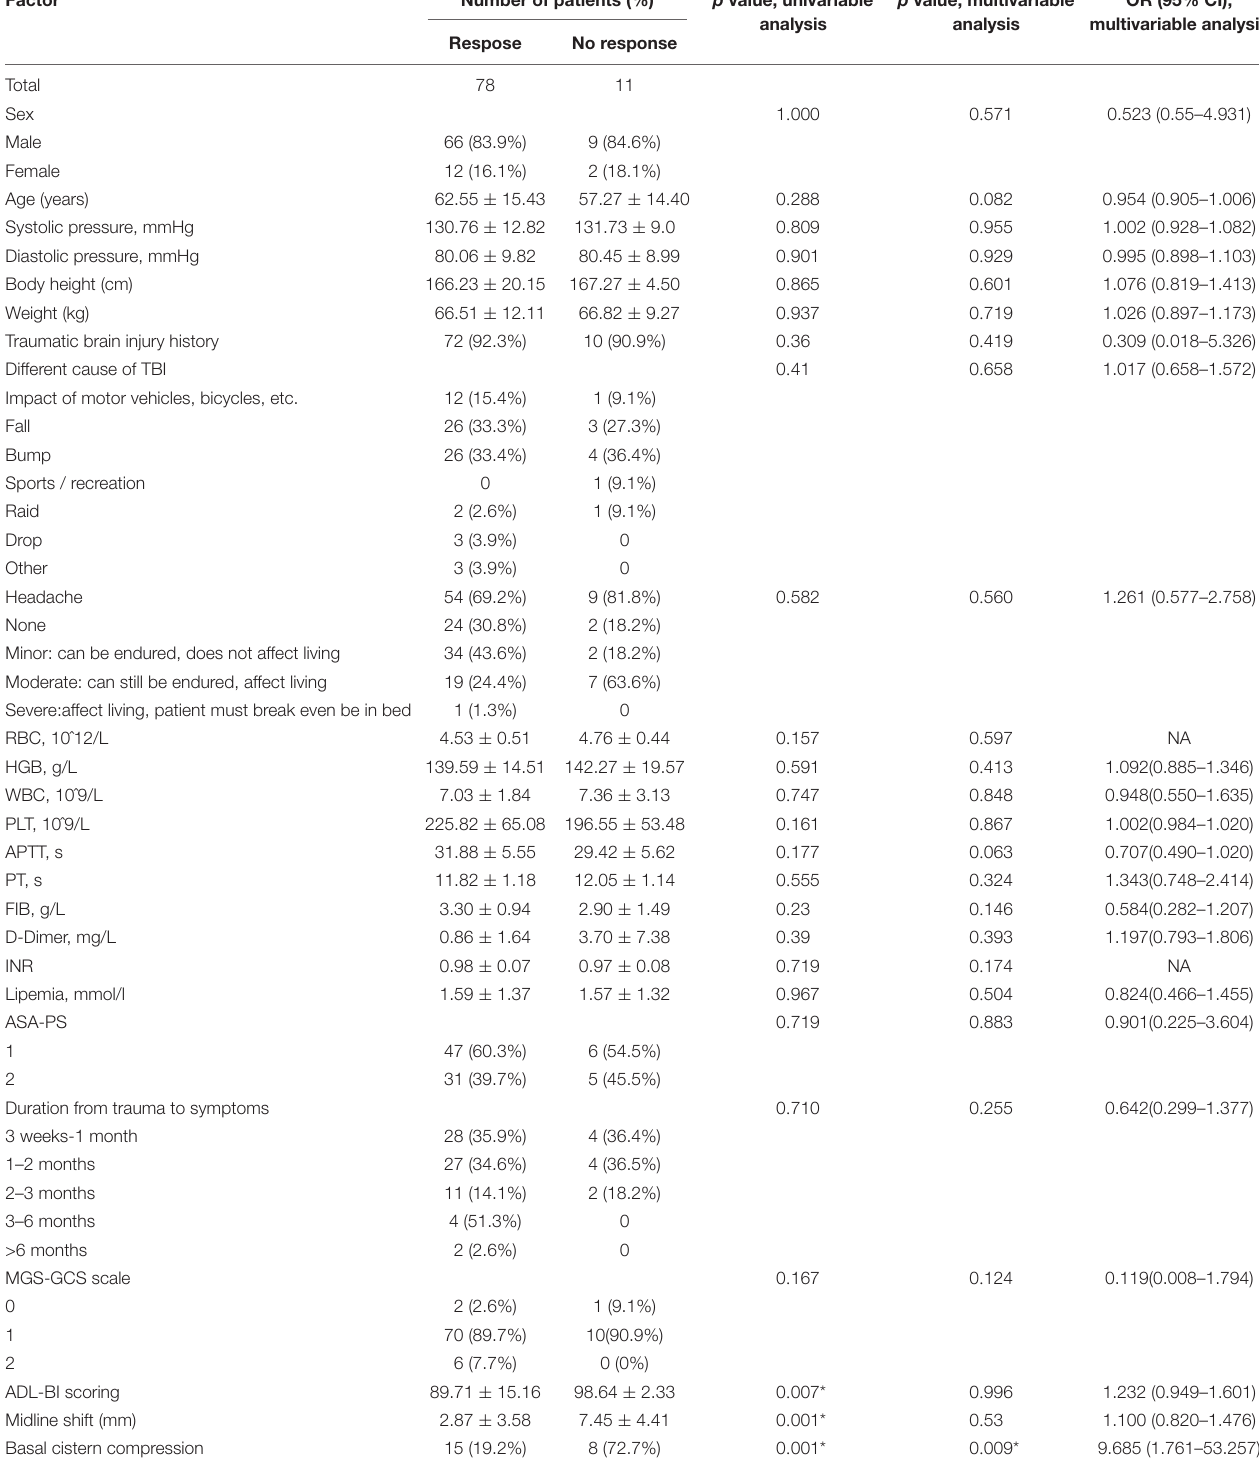
TABLE 5 | Factors related to outcome of atorvastatin as a monotherapy for chronic subdural hematoma: univariate analysis and multivariable analysis.